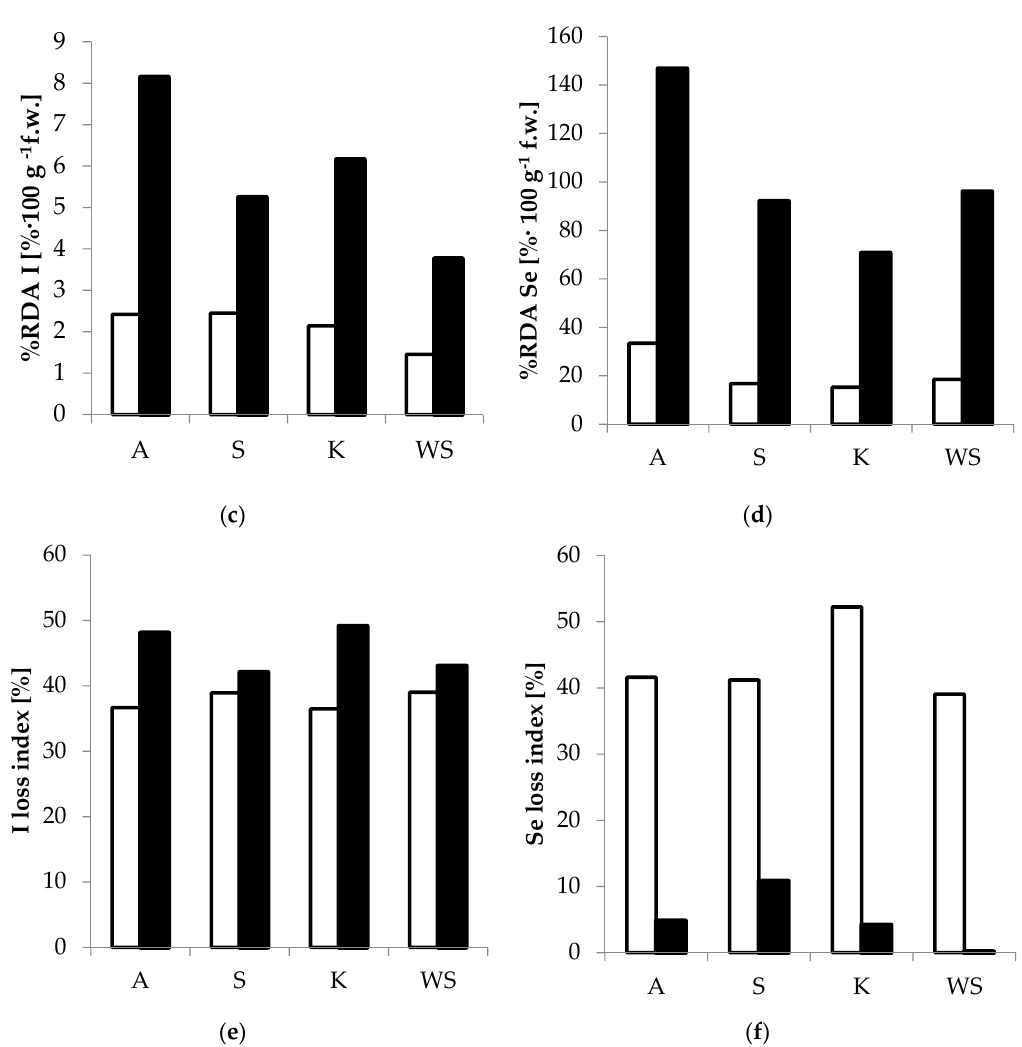
Figure 2. Iodine and selenium parameters. ( a ) Content of iodine; ( b ) Content of selenium; ( c ) %RDA of iodine; ( d ) %RDA of selenium; ( e ) Loss index of iodine; ( f ) Loss index of selenium. White bars, control carrot juice (CJ) and black bars, biofortified carrot juice (BCJ). Various types: A, Askona F1; S, Samba F1; K, Kazan F1; WS, White Satin. Mean ± SE, the same letters set no differences at p < 0.05.